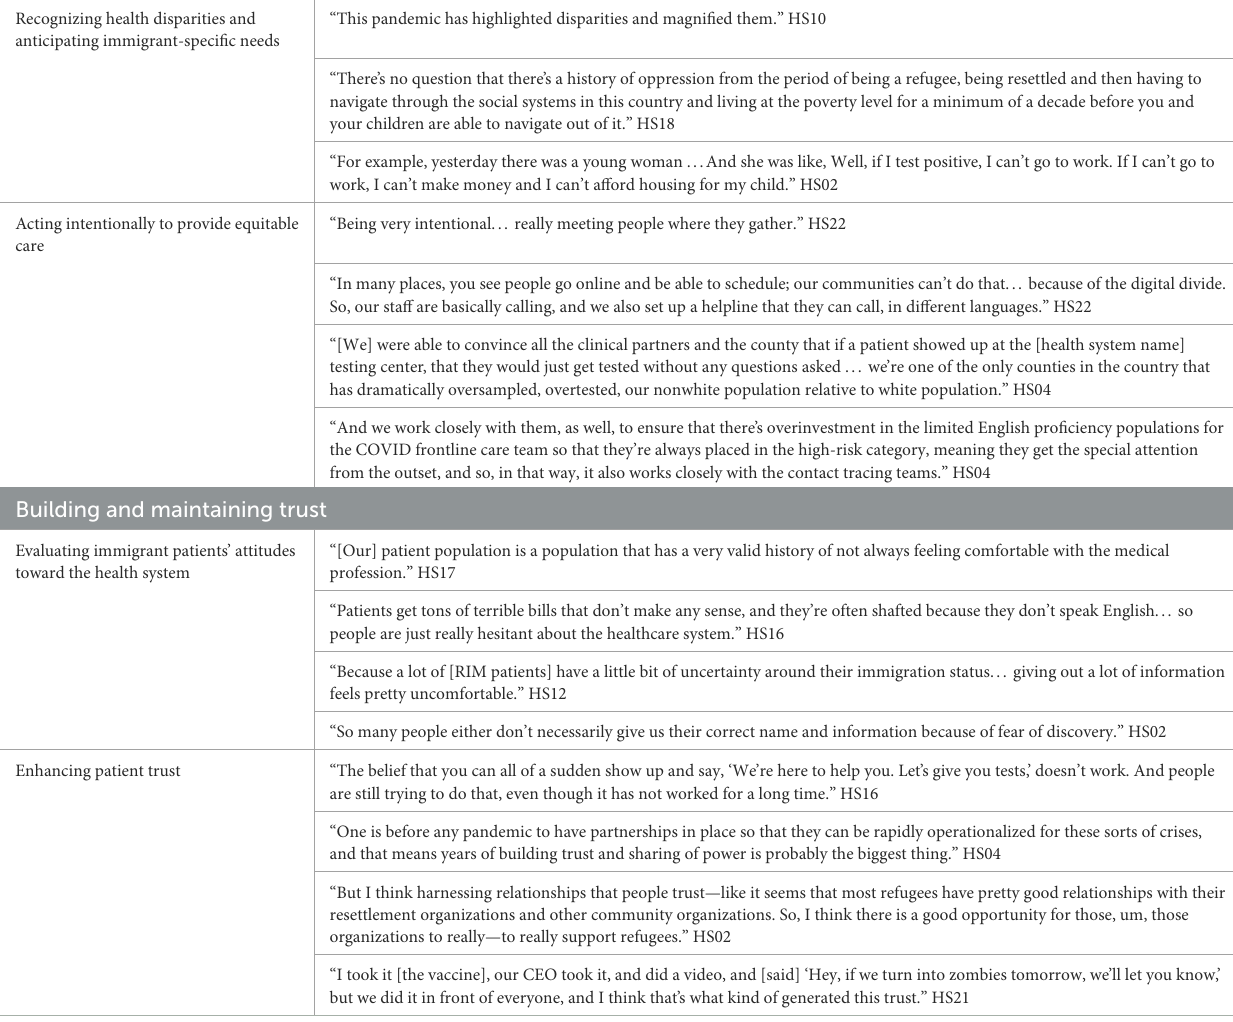
TABLE 3 Foundational